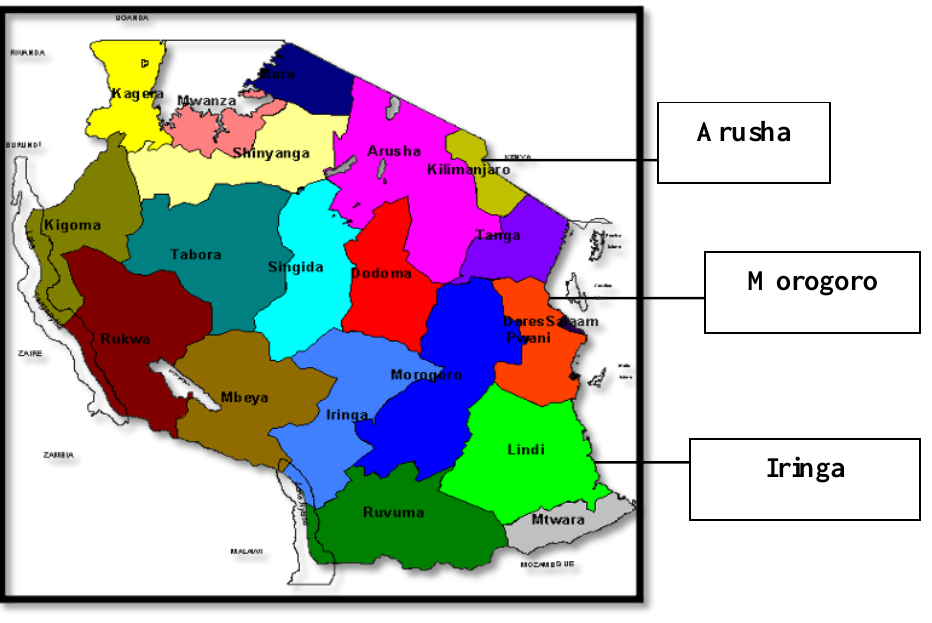
Figure 1: Geographical Locations of Study Areas Source: Consulate of the United Republic of Tanzania